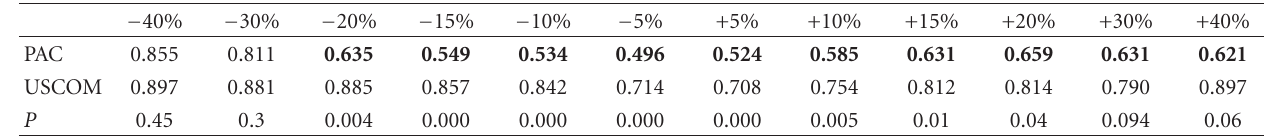
Table 3: ROC area under the curve (AUC) values for detection of increased and decreased percentage changes of CO relative to FP where P is significance of di ff erence between the two measures. An AUC of 1 represents perfect sensitivity, 0.7 represents clinically acceptable sensitivity to change, while 0.5 is a random relationship.